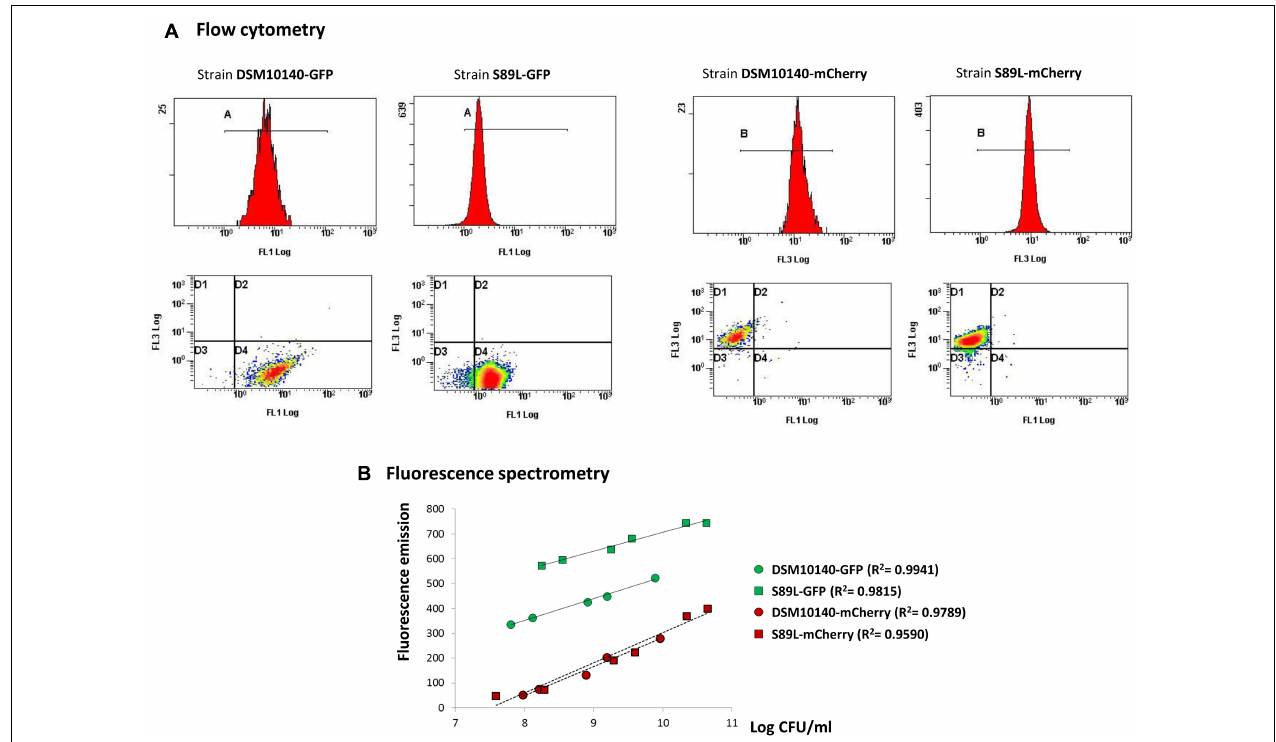
FIGURE 3 | Fluorescence quantification of GFP (the two left panels) and mCherry proteins (the two right panels) of the bifidobacterial strains harboring the corresponding plasmids using the Cytomics FC500 flow cytometer; see Supplementary Figure S2 for correlation with bacterial enumeration in agar-MRSc (A) . Linear regression between the fluorescence emitted, recorded by the CaryEclipse fluorescence spectrometer, and the bacterial counts (Log CFU/ml) of seriated dilutions of the fluorescent bifidobacterial suspensions; the coefficients of determination ( R 2 ), showing how well data fit to the regression line equations, are indicated in bold letters (B)